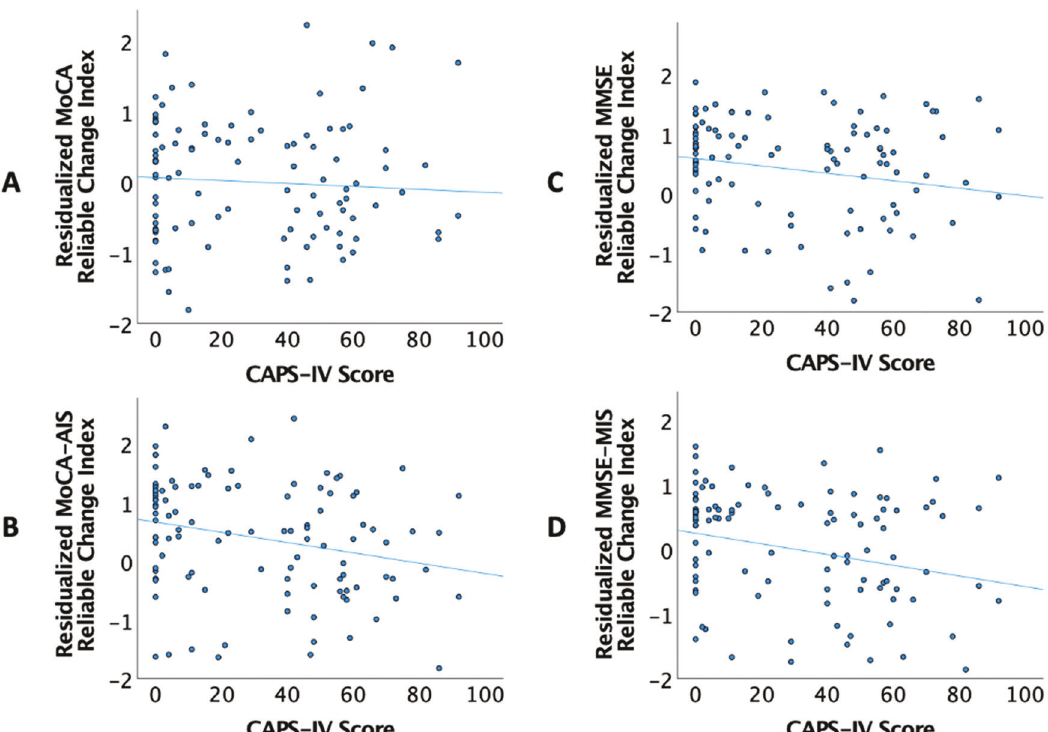
Fig. 1 PTSD symptom severity and cognitive change. Higher scores on CAPS-IV were associated with greater decline in cognition. Values on the x -axis represent the CAPS-IV scores. Values on the y -axis represent standardized residuals of change in ( A ). MoCA total score, B attention index of the MoCA, and C MMSE total score, D memory index of the MMSE (accounting for age, education, history of TBI, baseline cognitive scores, A β 42, t-tau, and p-tau). MoCA-AIS Attention Index Score of the MoCA; MMSE-MIS Memory Index Score of the MMSE; CAPS-IV Clinician- Administered PTSD Scale; A β 42 Beta-amyloid; t-tau total tau; p-tau phosphorylated